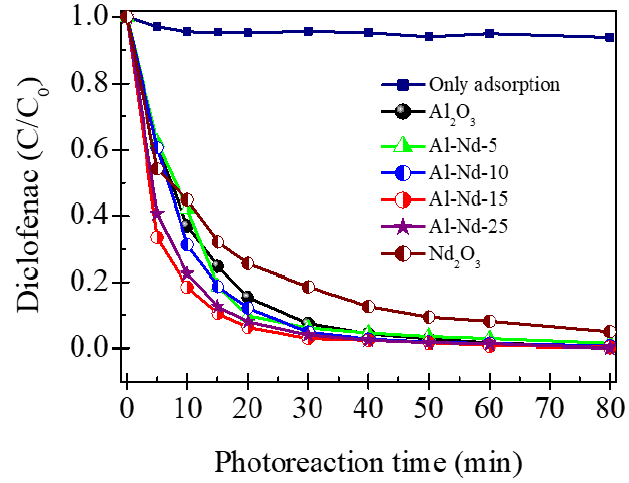
Figure 10. Relative concentration (C / C 0 ) of diclofenac as a function of the photoreaction time using γ -Al 2 O 3 , Al-Nd- x binary oxides, and Nd 2 O 3 as photocatalysts; inset plot represents the diclofenac adsorption with dark light over Al-Nd-15 binary oxide.